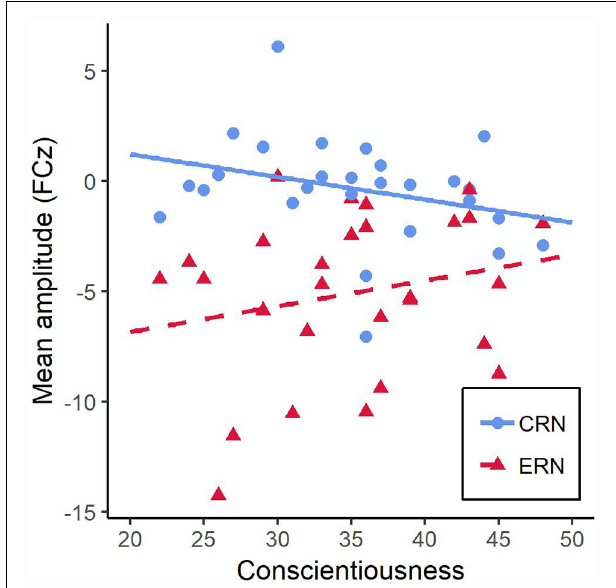
FIGURE 4 | Mean amplitudes during 20–70 ms post-response interval at electrode FCz as a function of conscientiousness for correct (CRN) and incorrect responses error-related negativity (ERN). The lines resulted from regressing CRN and ERN amplitudes onto conscientiousness.